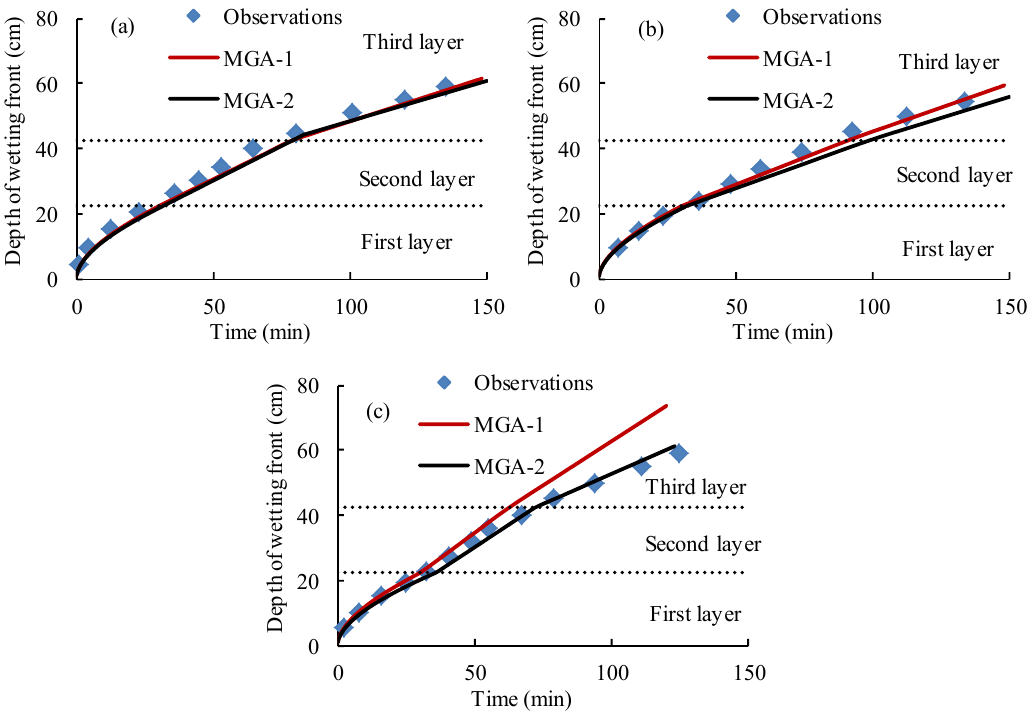
Figure 9. Comparison of the observed cumulative infiltration and the calculated value with the modified Green ‐ Ampt models for cases ( a ) L1S1L1, ( b ) L1S2L1, and ( c ) L1S3L1 in Experiment I.